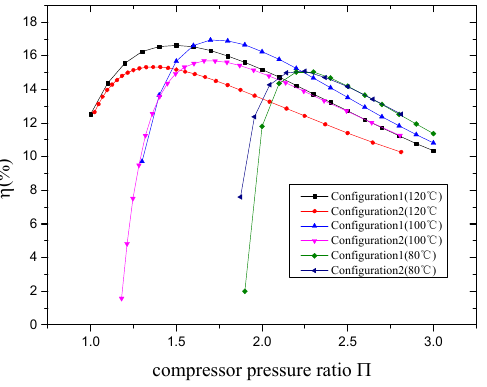
Figure 15. η versus π at di ff erent T GEN for both hybrid cycles.